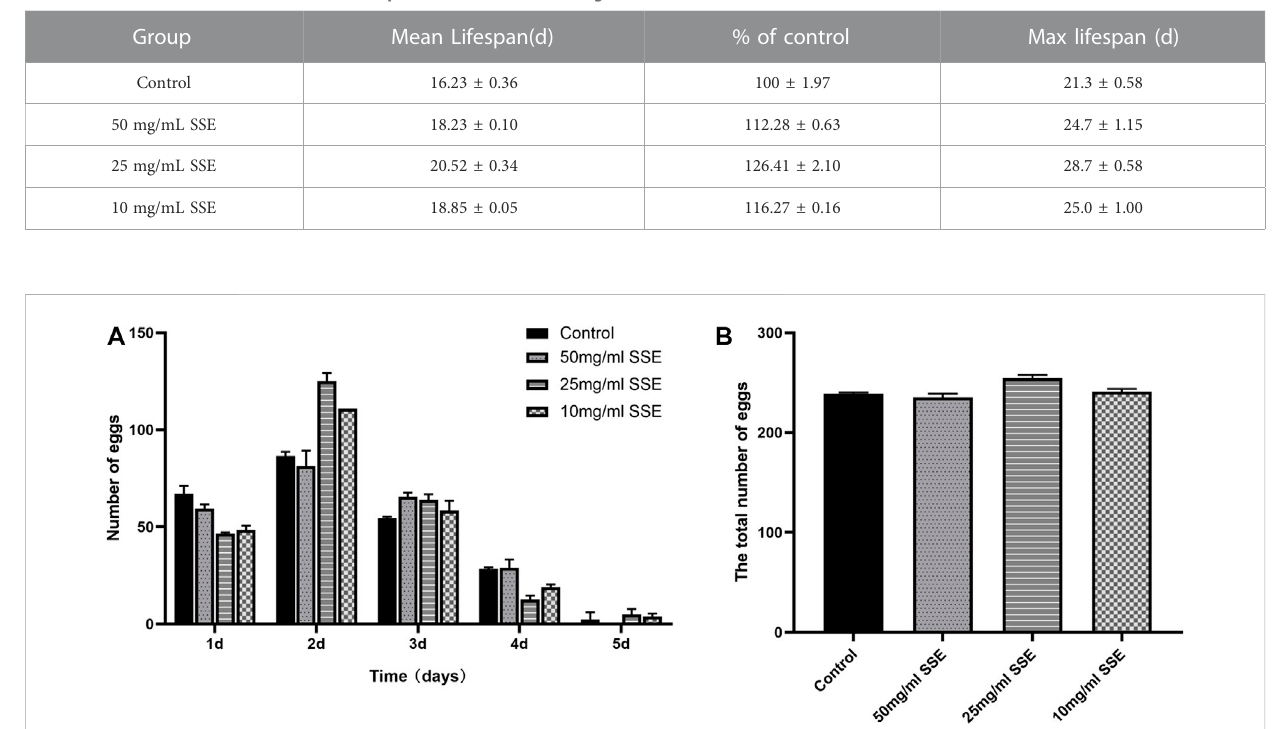
FIGURE 2 Effects of SSE on the reproductive capacity of Caenorhabditis elegans . (A) Numbers of eggs laid per day after SSE treatment. (B) The SSE treatment had no obvious effect on reproduction ( p > 0.05). All data were determined in triplicate (mean ± SD, n = 3).